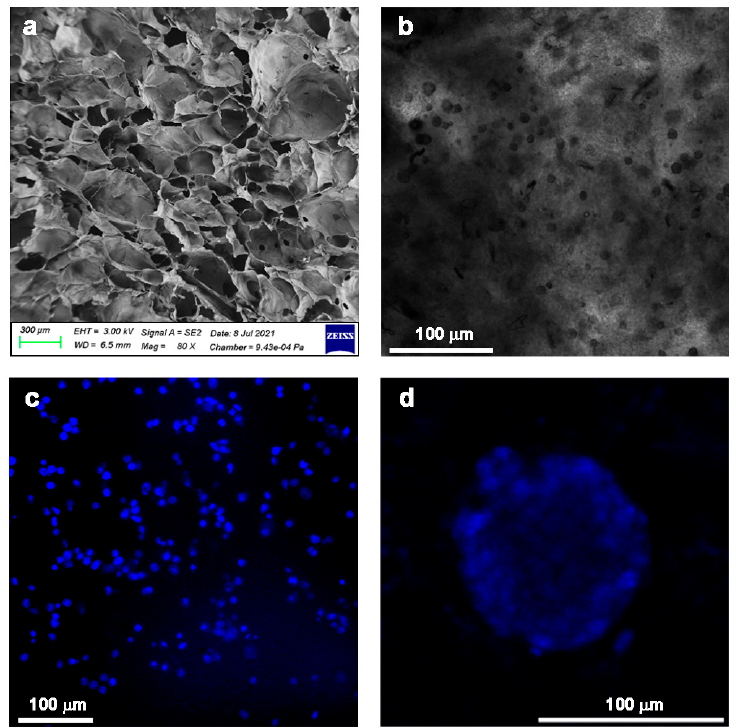
Figure 6. Injectable thermosensitive Ch–Pec IPN for colon rectal cancer in vitro modeling: ( a ) morphological analysis of the hydrogel structure by scanning electron microscopy; ( b , c ) bright field and fluorescence optical microscopy investigation at 24 h of HTC 116 cell culture in the Ch–Pec hydrogel; ( d ) fluorescence optical microscopy investigation of spheroids formed and grown in Ch– Pec hydrogels after 21 days of culture